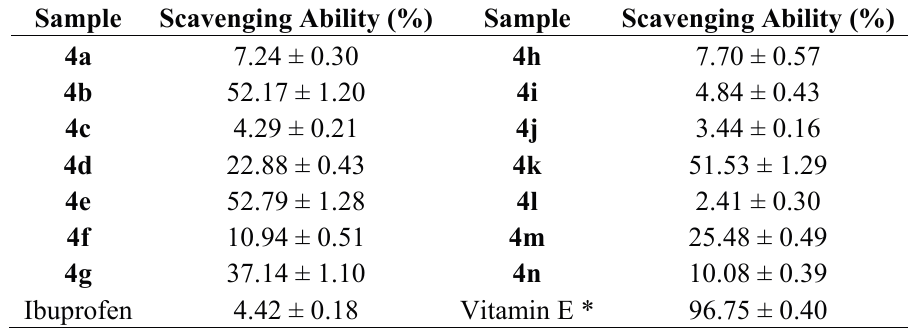
Table 7. The ABTS radical scavenging ability of the thiazolidine-4-one derivatives 4a – n